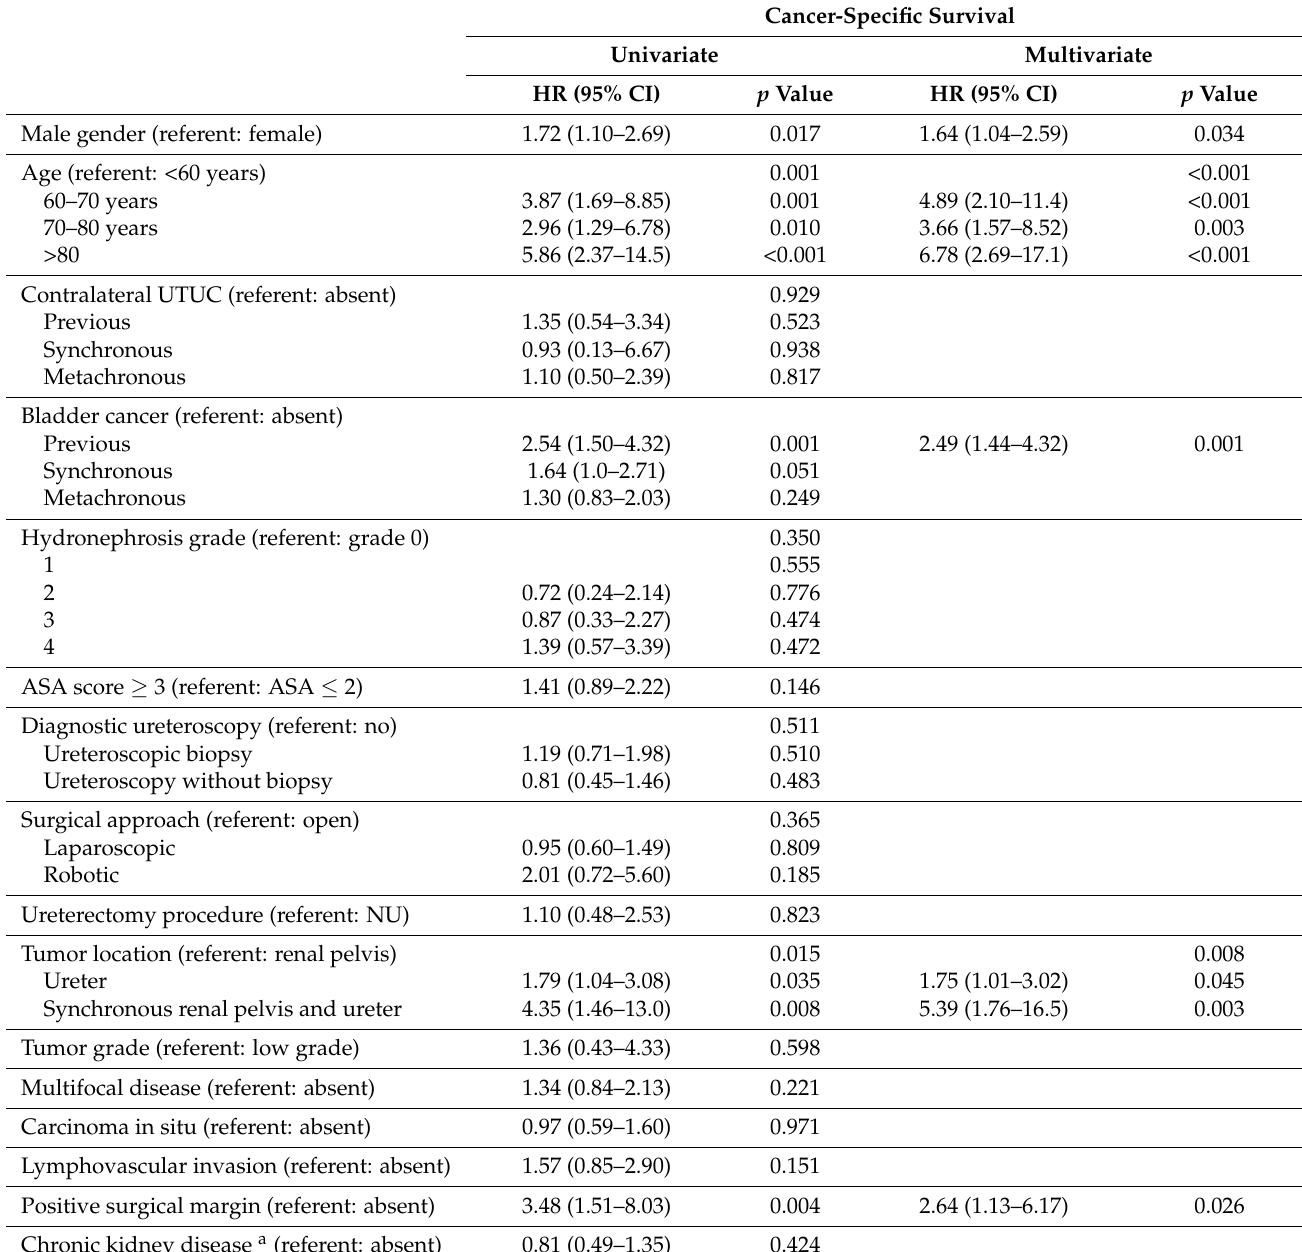
Table 3. Univariate and multivariate analysis predicting prognostic factors for cancer-specific survival in the patients with pT2 UTUC after radical surgery. Cancer-Specific Survival Univariate